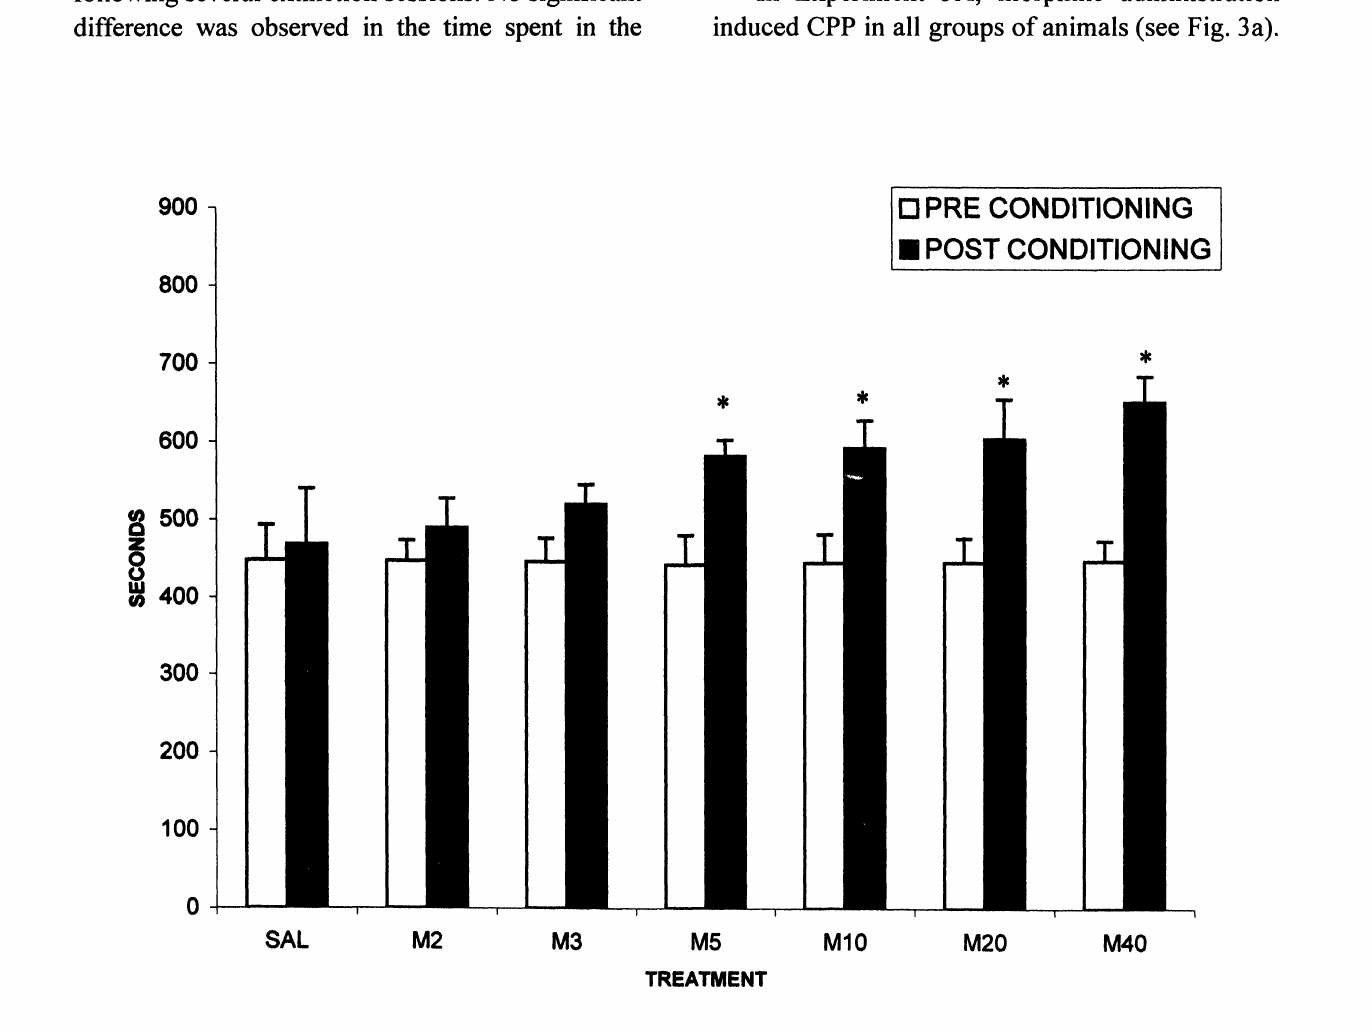
Fig. 1: Effects of different doses of morphine on the acquisition of a CPP. Bars represent the mean (+SEM) time spent in the drug-paired compartment before conditioning session ( 1-1 and after conditioning session ( ). During conditioning, animals were divided into the following treatment groups: SAL, saline; M2, morphine 2 mg/kg; M3, morphine 3 mg/kg; M5, morphine 5 mg/kg; M10, morphine 10 mg/kg; M20, morphine 20 mg/kg; M40, morphine 40 mg/kg; * p < 0.01, significant difference in time spent in pre-conditioning vs. post-conditioning